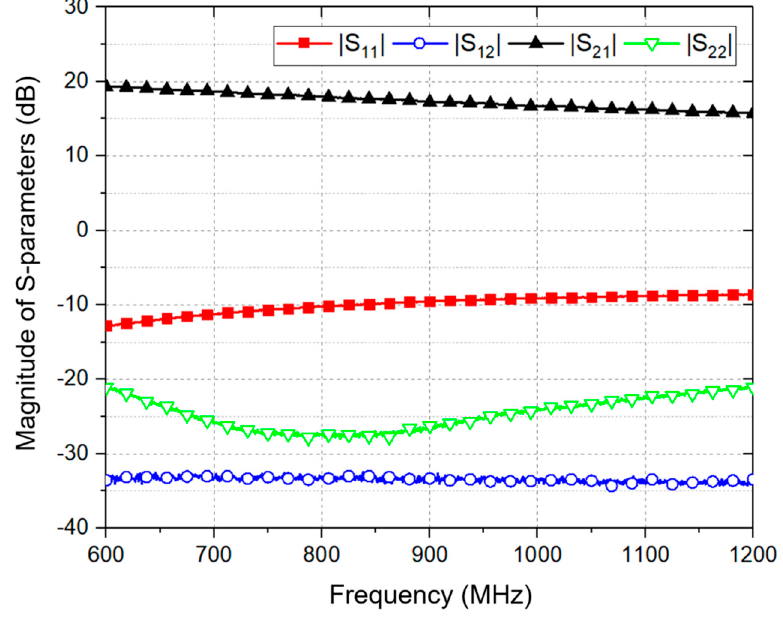
Figure 6. Magnitudes of measured S-parameters of the proposed LNA.